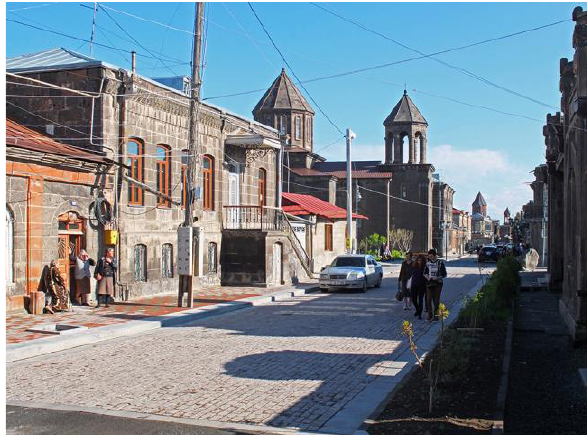
Figure 5. Vernacular ensemble of Abovyan Street.